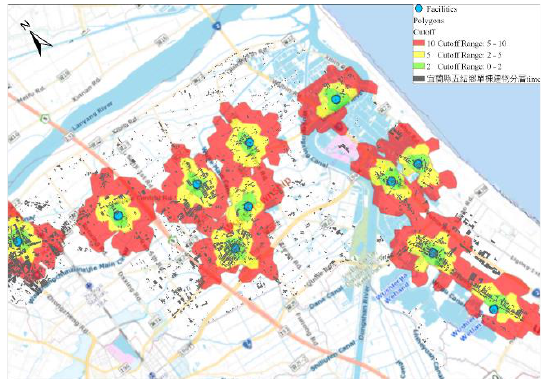
Figure 16. Evacuation visualization combining with service area